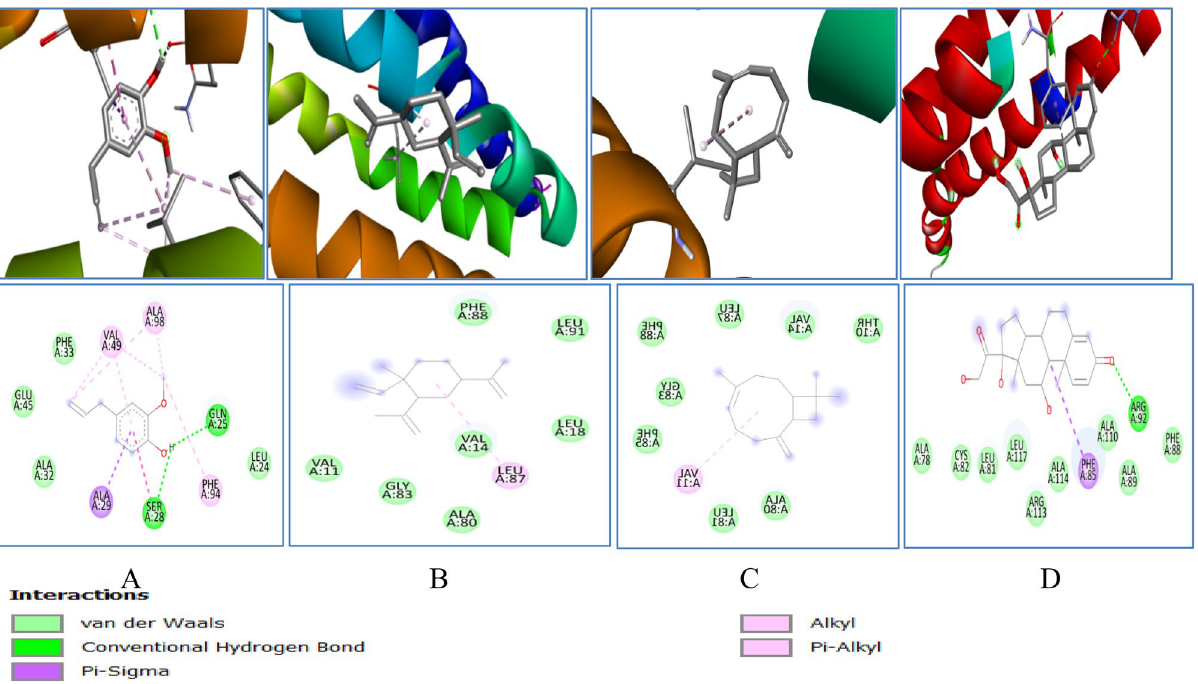
Figure 12. 3D (to the upper panel) and 2D (to the lower panel) interaction diagrams of (A) Eugenol, ( B ) Cyclohexane ( C ) Caryophyllene ( D ) Prednisolone with the crystal structure of Glutathione Peroxidase (PDB ID: